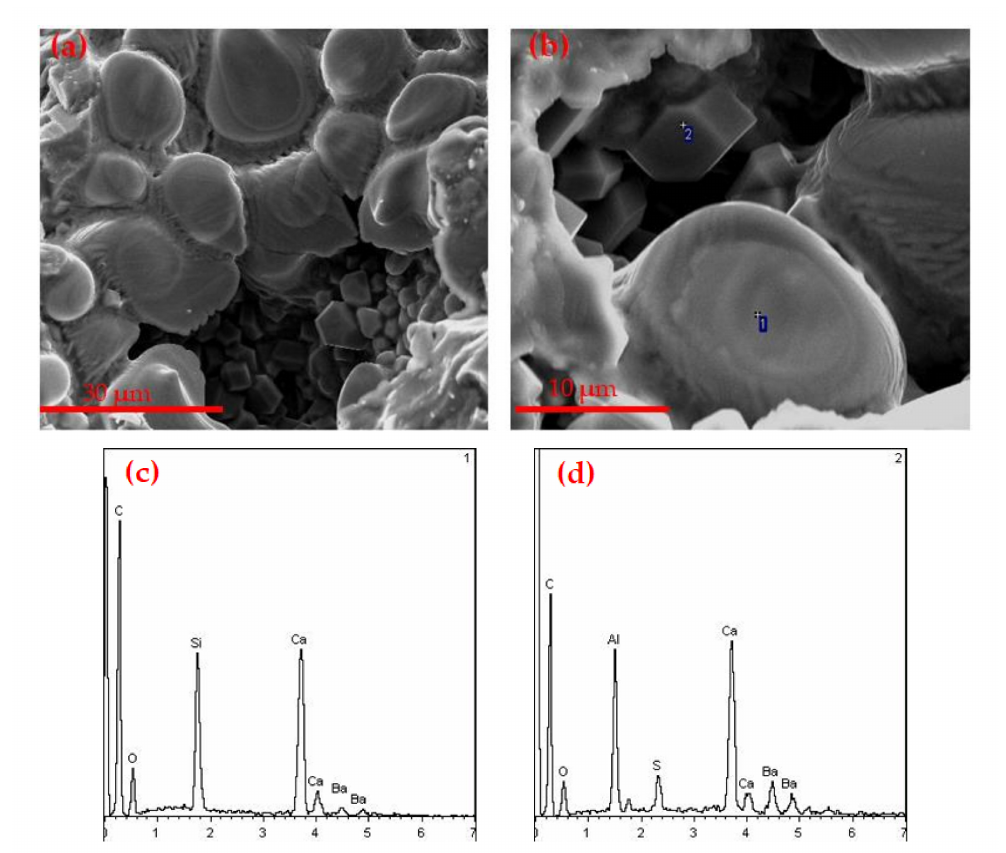
Figure 14. ( a , b ) SEM-EDS of CF3 clinker at 1350 °C, ( c ) 1-EDS, ( d ) 2-EDS.